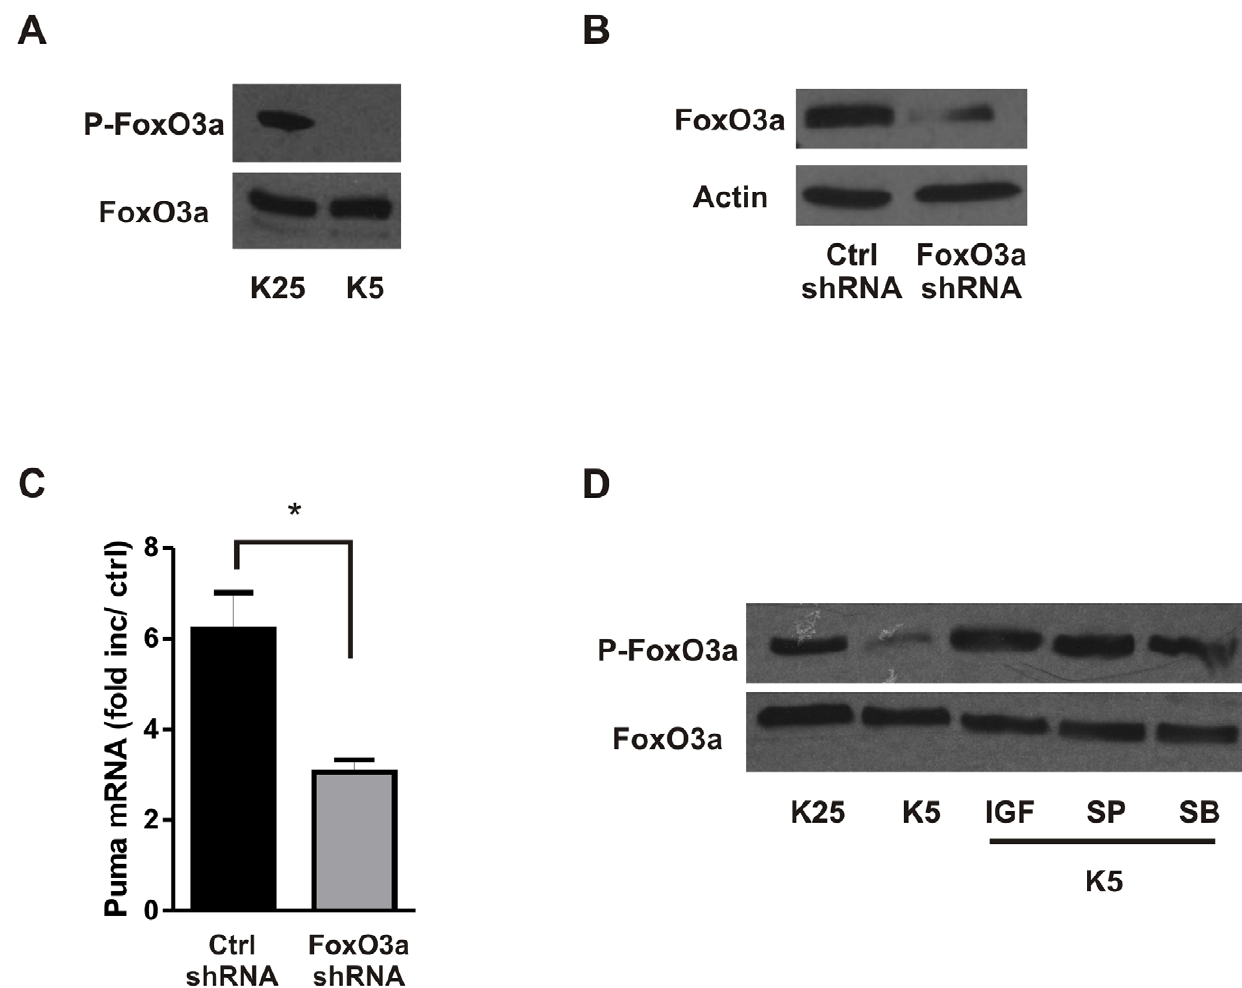
Figure 10. FoxO3a regulates Puma induction in potassium deprived CGNs. A, CGNs were maintained in high potassium (K25) or subjected to potassium withdrawal (K5). Protein extracts were collected at 8 hours and Phospho(Thr32)-FoxO3a and total FoxO3a levels were analyzed by western blot. B, CGNs were transduced with lentivirus (1 MOI) expressing shRNA directed against FoxO3a or a non-targeting control shRNA and FoxO3a protein levels were analyzed by western blot at 7 days post-infection. C, Puma mRNA levels were measured by qRT-PCR following 8 hours of potassium deprivation in CGNs transduced with FoxO3a-shRNA or non-targeting control shRNA (n=3; *p , 0.05). D, Phospho(Thr32)-FoxO3a and total FoxO3a protein was analyzed by western blot in CGNs maintained in high potassium (K25) or subjected to potassium deprivation for 8 hours in the presence or absence of either IGF-1 (200 nM), SP600125 (10 m M) or SB415286 (30 m M).